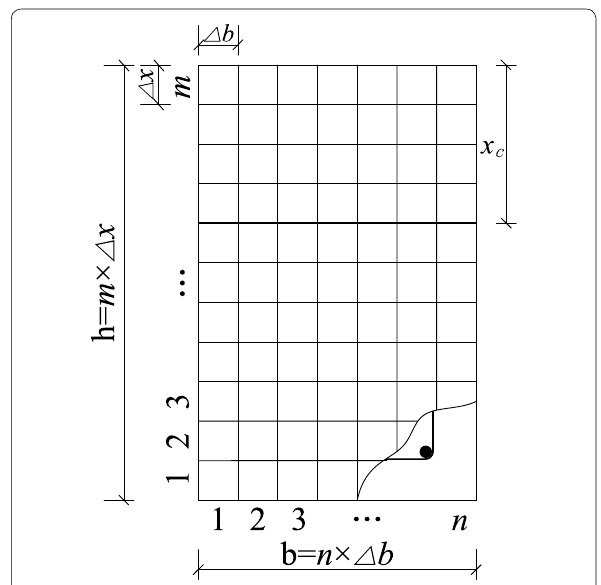
Fig. 19 Section unit division of